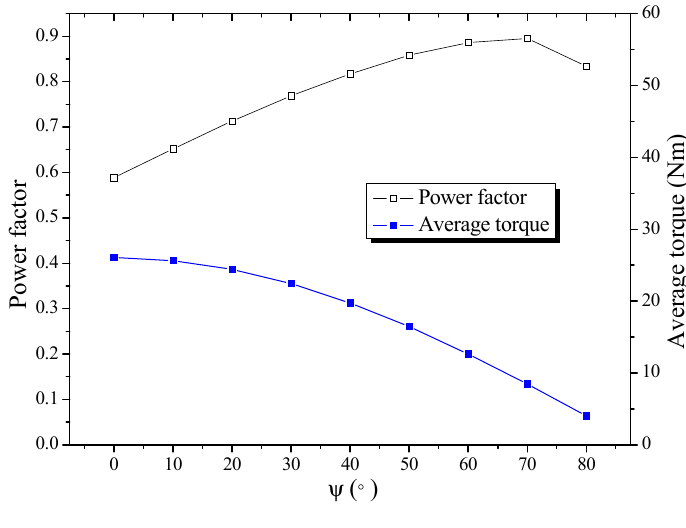
Figure 7. Power factor and average torque versus ψ